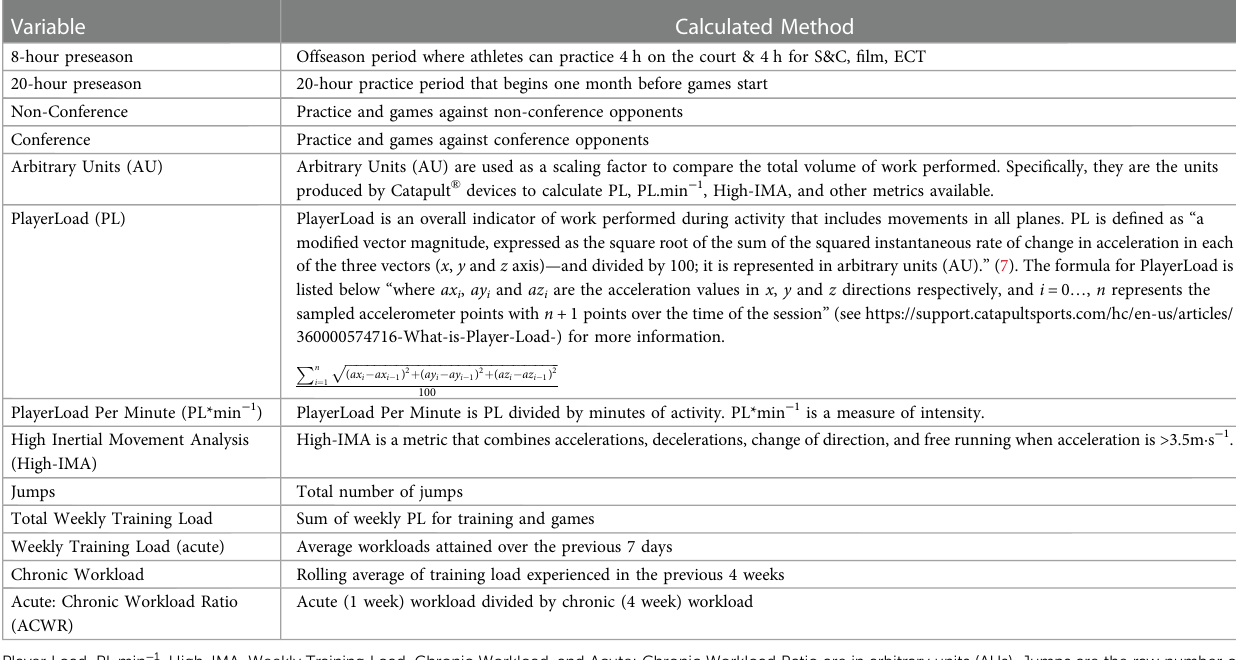
TABLE 1 Common workload